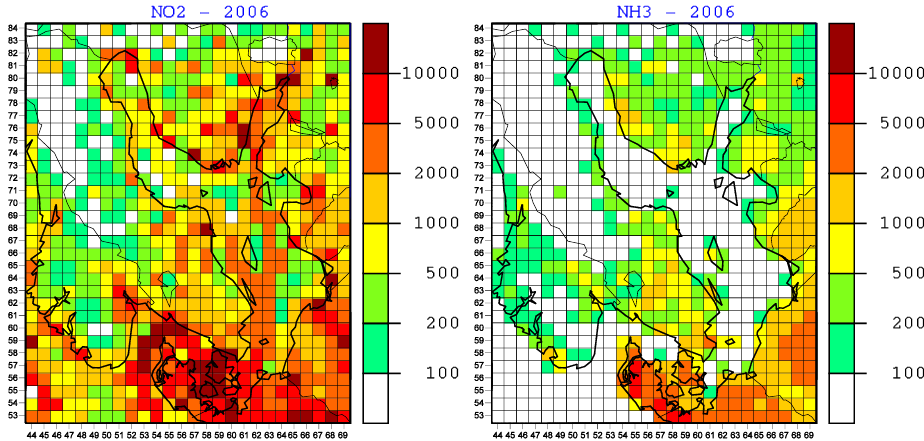
Fig. 3. Spatial distribution of annual 2006 nitrogen dioxide emissions (left) and annual 2006 ammonia emissions (right) in the model grid covering the Baltic Sea region. Units: MgN per year and per grid.